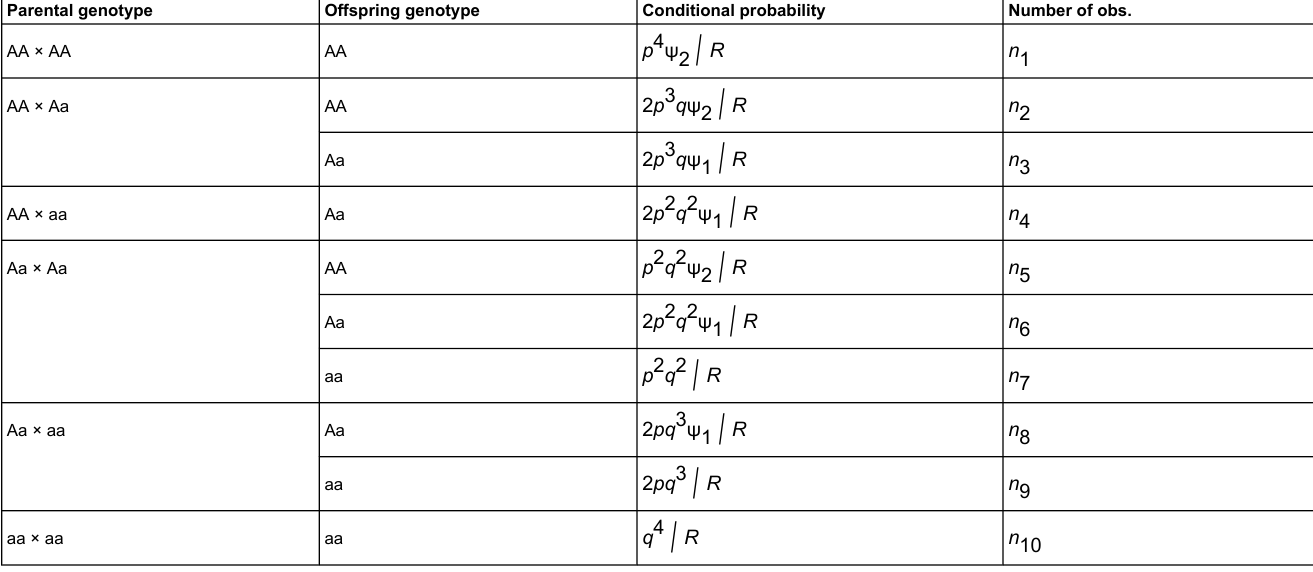
Table 1: Conditional probabilities of parental genotype and offspring genotype given that offspring is affected (for the triad families). Parental genotype Offspring genotype Conditional probability Number of obs.